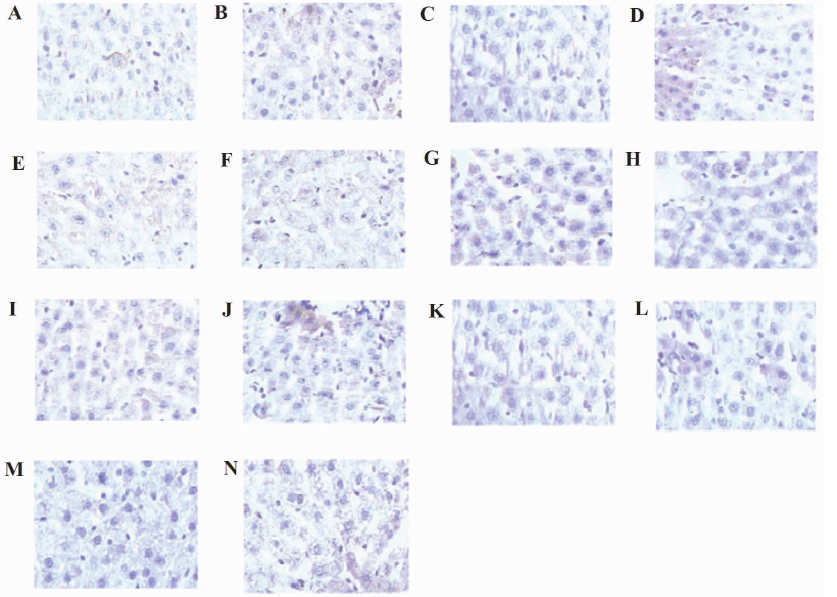
Figure 3. Immunohistochemical staining of Bcl-2 and Bax in liver tissue. A, Bcl-2 of control group; B, Bax of control group; C, Bcl-2 of one week exercise-training group; D, Bax of one week exercise-training group; E, Bcl-2 of one week stimulating group; F, Bax of one week stimulating group; G, Bcl-2 of three weeks exercise-training group; H, Bax of three weeks exercise-training group; I, Bcl-2 of three weeks stimulating group; J, Bax of three weeks stimulating group; K, Bcl-2 of five weeks exercise-training group; L, Bax of five weeks exercise-training group; M, Bcl-2 of five weeks stimulating group; N, Bax of five weeks stimulating group. doi:10.1371/journal.pone.0075093.g003 (Figure 2C and 2D). After three weeks exercise-training, liver cells and mitochondria were swell, hepatic sinusoid was narrow, and rough endoplasmic reticulum (RER) was expanded (Figure 2E); while, after three weeks stimulating, liver cells and mitochondria were slightly swell, RER was mildly expanded (Figure 2F). Then after five weeks exercise-training, the mitochondria displayed RER and glycogen were significantly decreased (Figure 2G). The